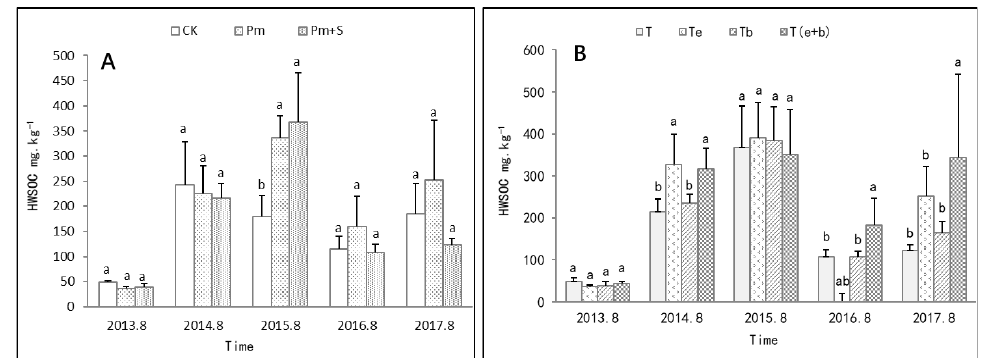
Figure 4. Dynamic change of soil hot water-soluble organic carbon content. Bars represent standard errors. Lower case letters above each panel show statistical significance at p < 0.05. CK pig manure, S slurry, e earthworms, b bacteria, T Pm + S, Te T + earthworms, Tb T + bacteria, T(e + b) T + earthworms + bacteria ( A ) Pig manure, biogas slurry agricultural use ( B ) Biological control.